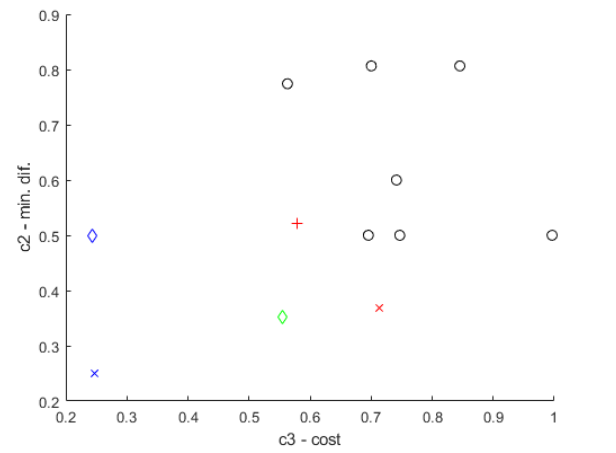
Figure 16. Particle Swarm Optimization. Swarm size: 100. Black ball—LHS. Others, see Table above.